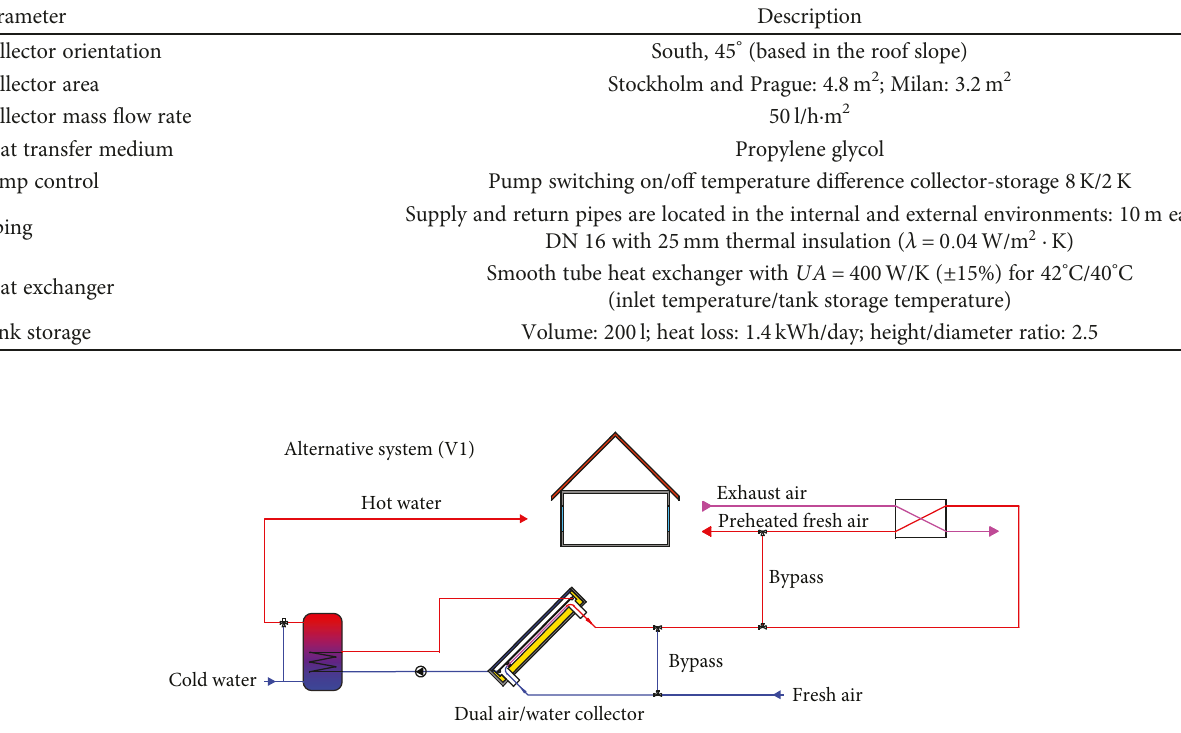
Figure 12: The con fi guration of the alternative system V1.